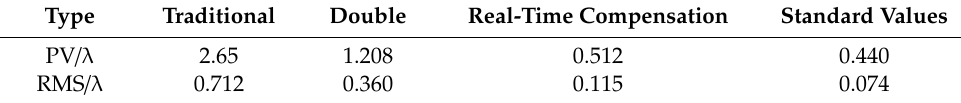
Table 1. Comparison of experimental results.